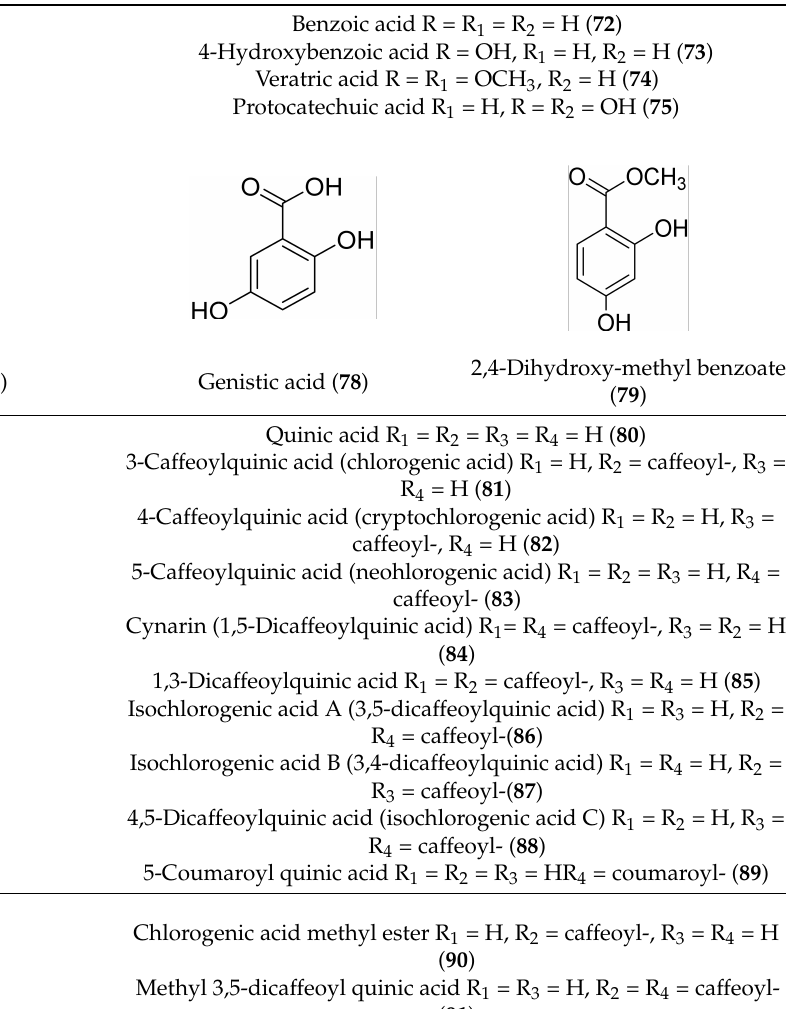
Table 6. Chemical structures of the phenolic and quinic acid derivatives from Achillea